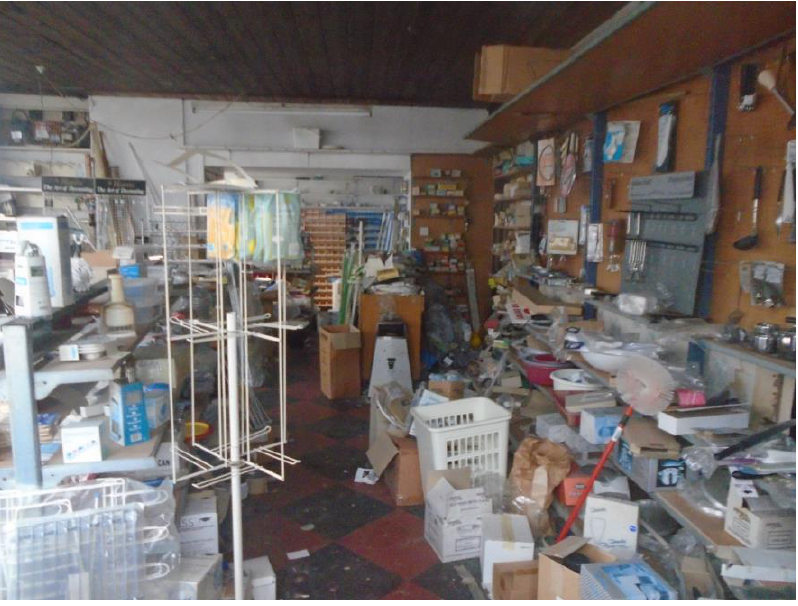
Figure 29. Abandoned hardware store.